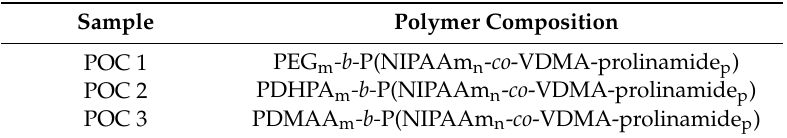
Table 2. Structure of the polymer-bound organocatalyst (POC) after post-polymerization attachment of the L-prolineamide.